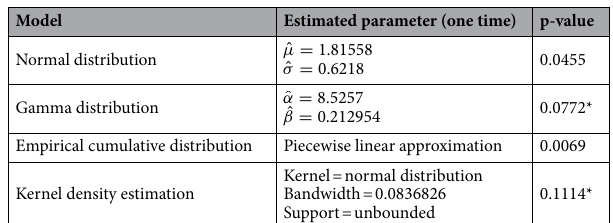
Model Estimated parameter (one time)